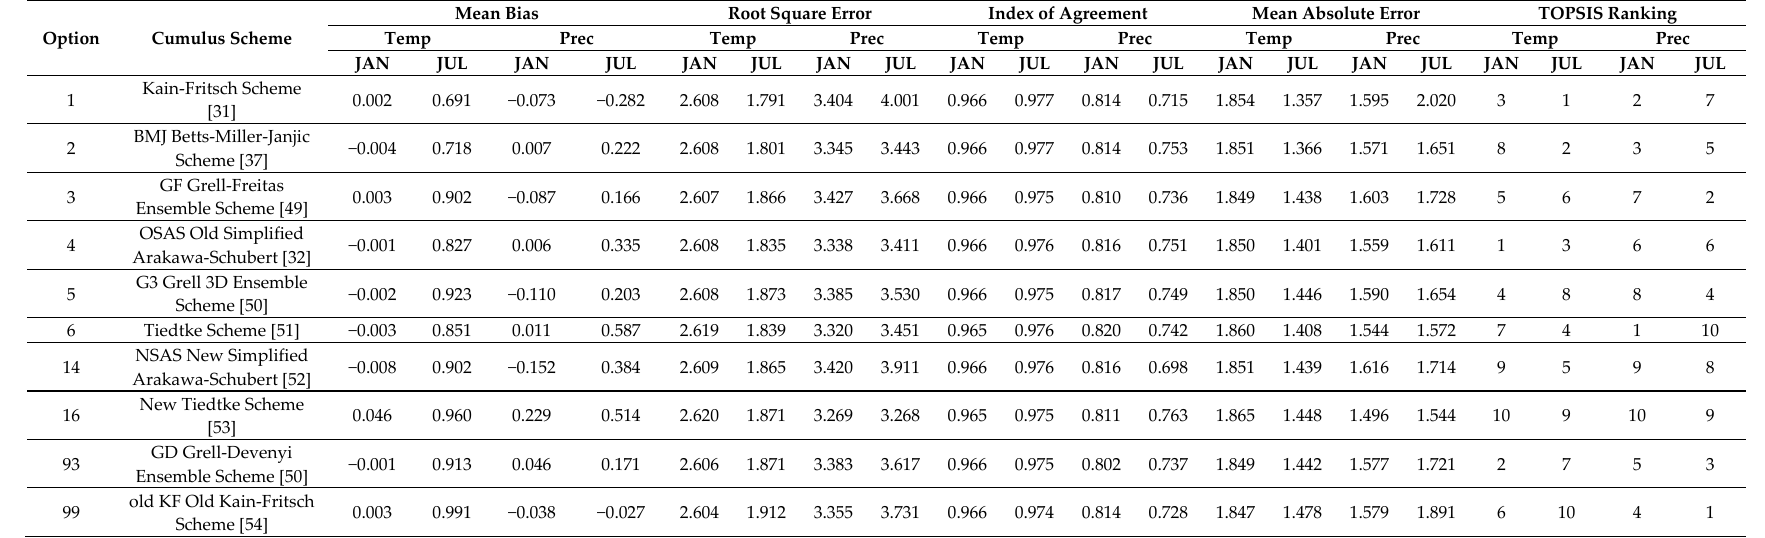
Table 4. Statistical measures and TOPSIS ranking for the Cumulus simulation group.